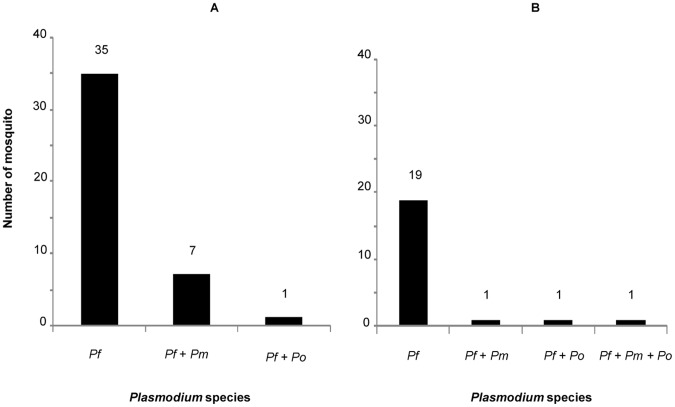
Prevalence of co-infection of Plasmodium spp in mosquitoes (An. gambiae and An. funestus) by Real-time PCR.The figure (A) shows results of speciation analysis of 43 positive samples of An. gambiae ss by qPCR. Of the 43 positive samples, 35 were infected by P. falciparum only (81%), 7 samples showed mixed infection with P. falciparum and P. malariae (16%), and a mixed infection with P. falciparum and P.ovale was observed in 1 sample (2%). The figure (B) shows results of analysis of 22 positive samples of An. gambiae ss by qPCR. Among the 22 positive samples, mono infection with P. falciparum was found in 19 samples (86%), 1 sample showed mixed infection with P. falciparum and P. malariae (4.5%), mixed infection with P. falciparum and P. ovale was observed in 1 sample (4.5%), and in 1 sample mixed infection with 3 species (P. falciparum, P. malariae and P. ovale) was noted (4. 5%).